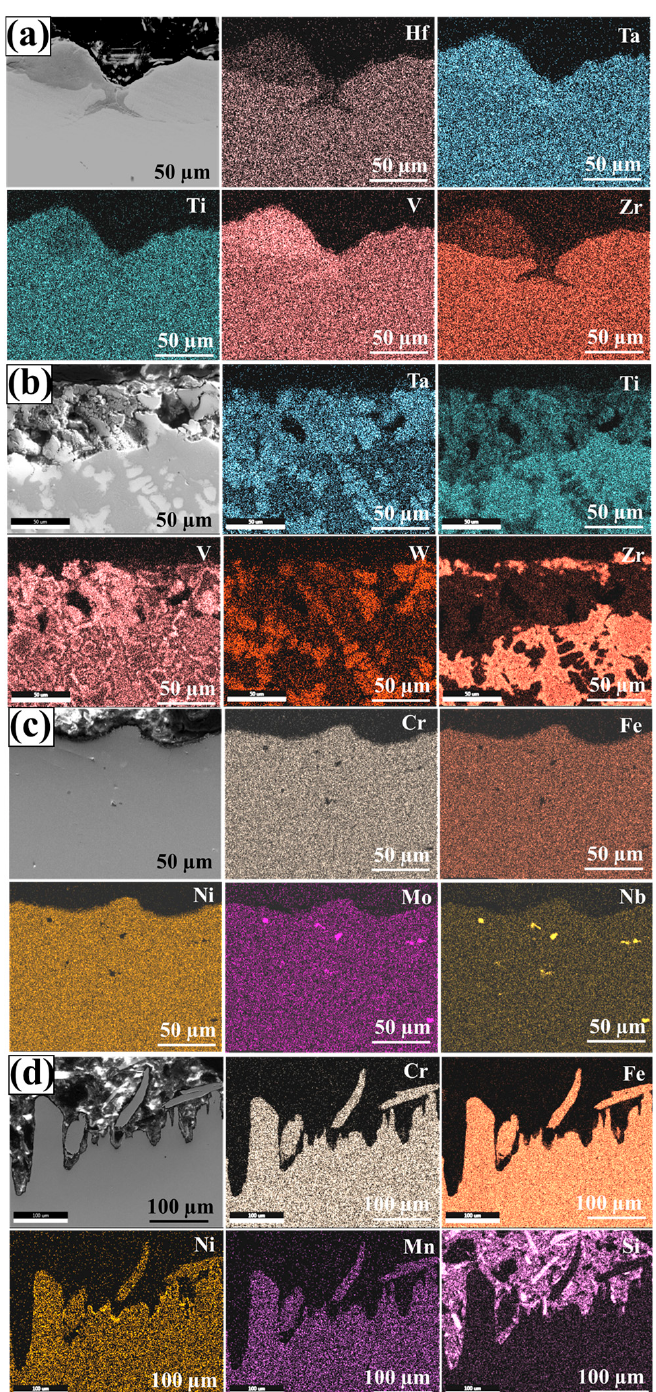
Figure 6. Cross-section EDS maps of the alloys exposed to molten FLiNaK salt under Ar atmosphere at 650 °C for: ( a ) HfTaTiVZr, ( b ) TaTiVWZr, ( c ) IN718, and ( d ) SS316.